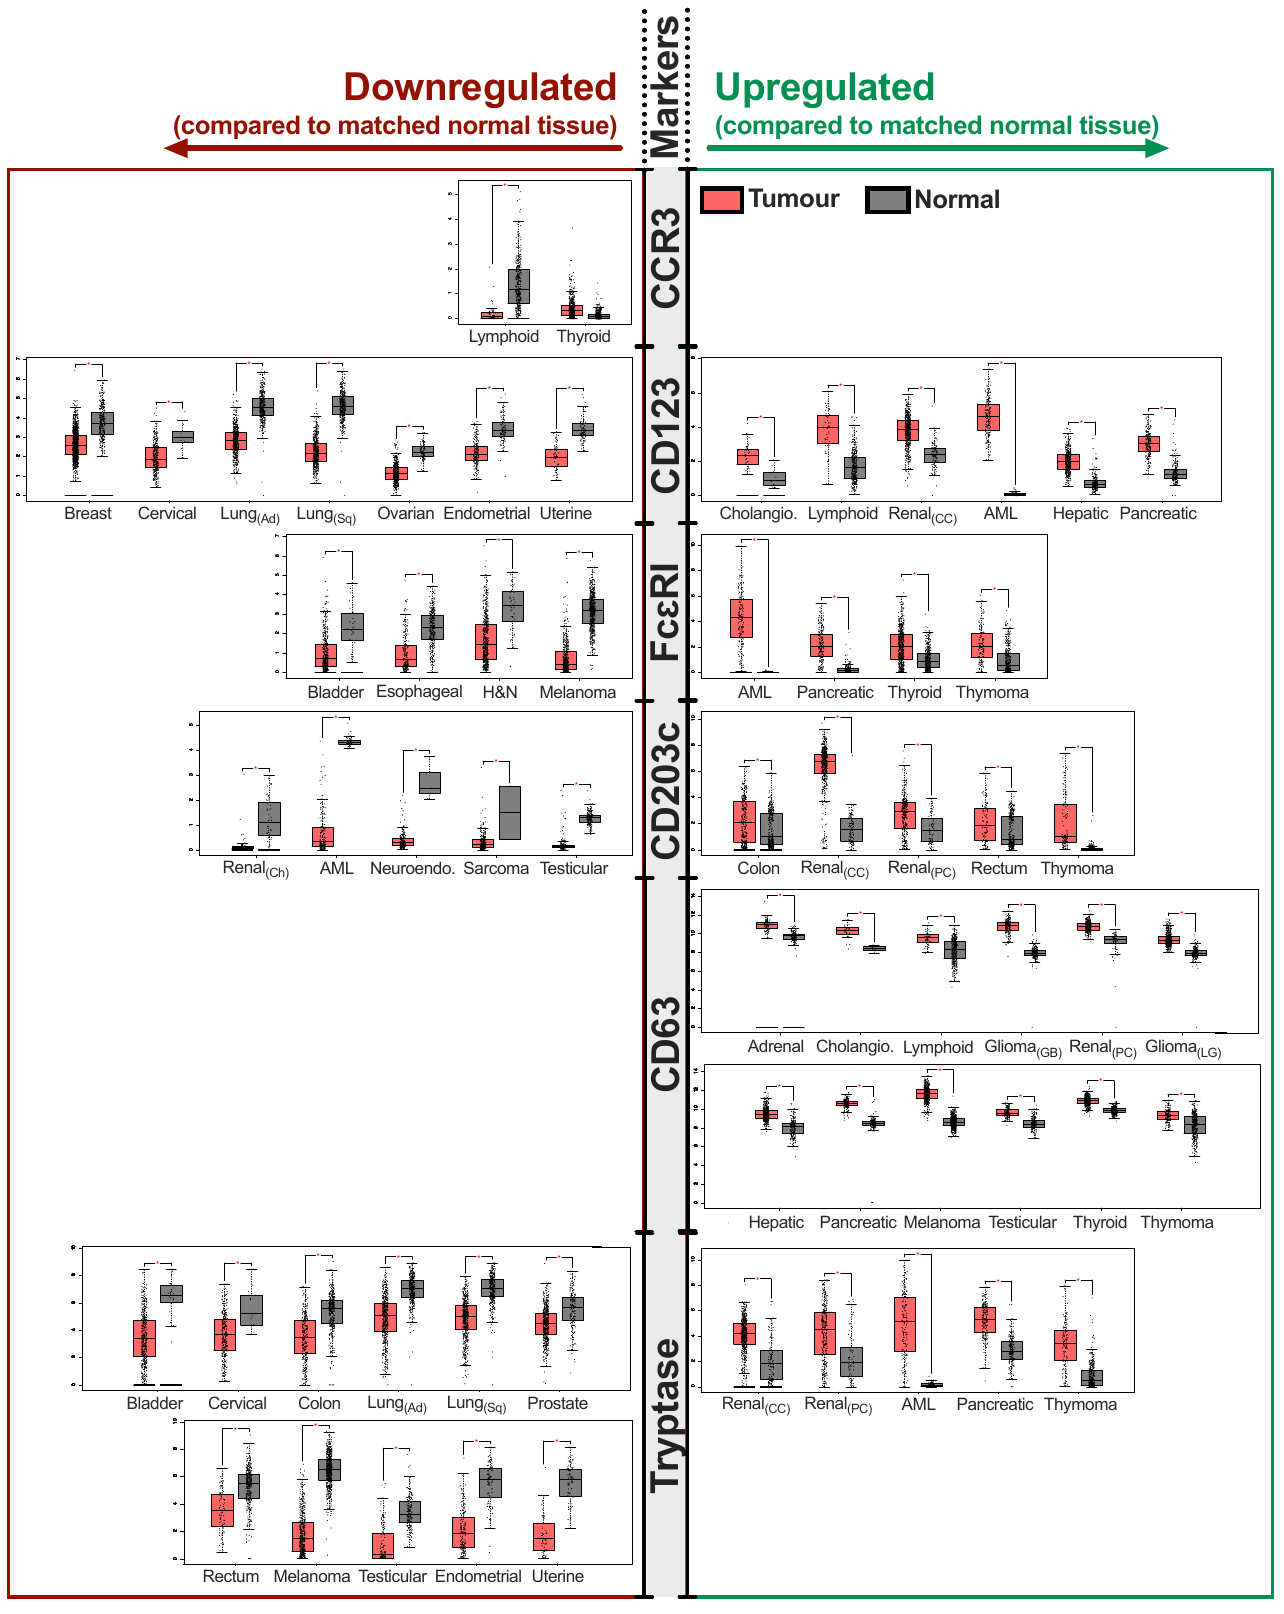
Figure 1. Significant changes in protein expression for basophil markers (CCR3, CD123, Fc ε RI) and basophil activation markers (CD63, CD203c, tryptase) measured in different tumor types (red)